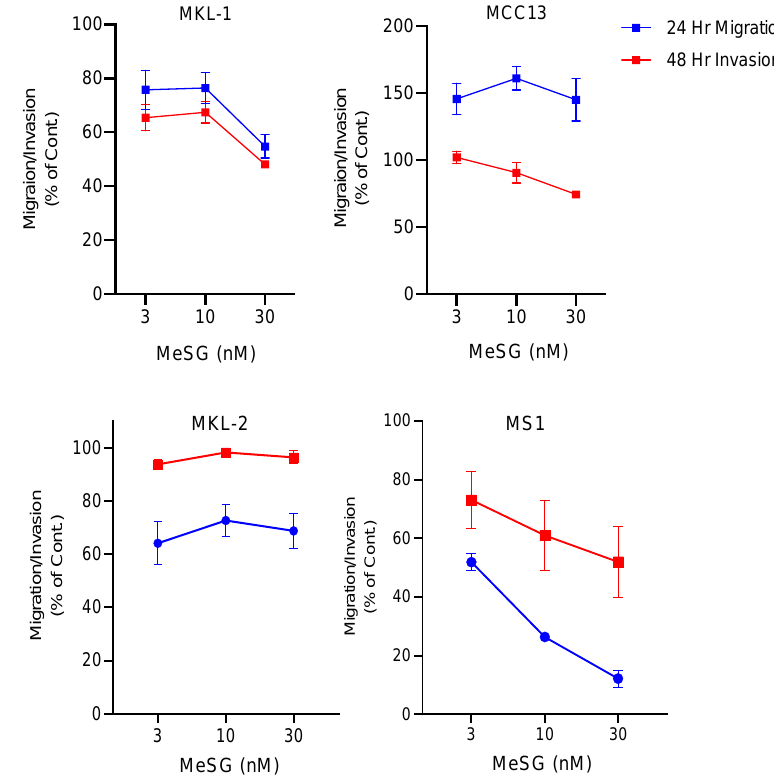
Figure 2. MeSG inhibits cell migration and invasion of MCC cell lines. VP-MCC (MS-1, MKL-1, MKL-2) and VN-MCC (MCC13) cells were seeded on a polycarbonate membrane (migration) or a polycarbonate membrane coated with a dried basement membrane matrix solution (invasion). Cells were allowed to migrate (24 h) or invade (48 h) toward 10% or 20% FBS in the presence or absence of 0, 3, 10, or 30 nM MeSG. Migrated or invaded cells on the bottom of the membrane were stained and quantified. At least three independent samples were analyzed (mean ± SEM).